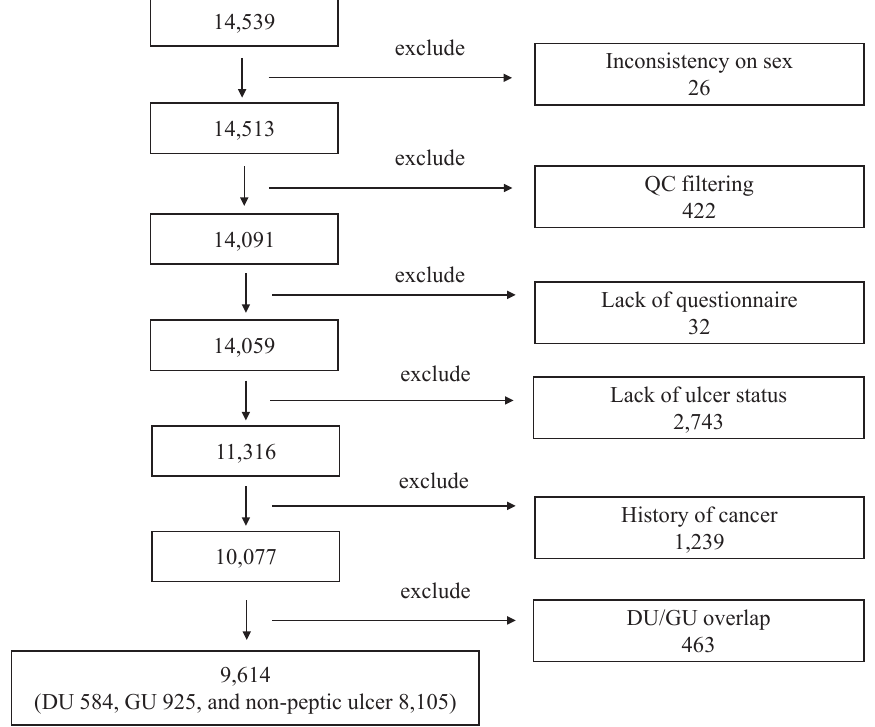
Figure 2. Study subject selection. A total of 14,539 participants were randomly selected for genotyping from 47,163 participants. We excluded 26 subjects because of inconsistent baseline information between the questionnaire and genotyping on sex; 422 whose genotype data did not meet quality control (QC) fi lters; 32 because of a lack of questionnaire data; 2,743 with a history of cancer; 1,239 with a lack of data on ulcer status; and 463 with DU / GU overlap cases. Finally,